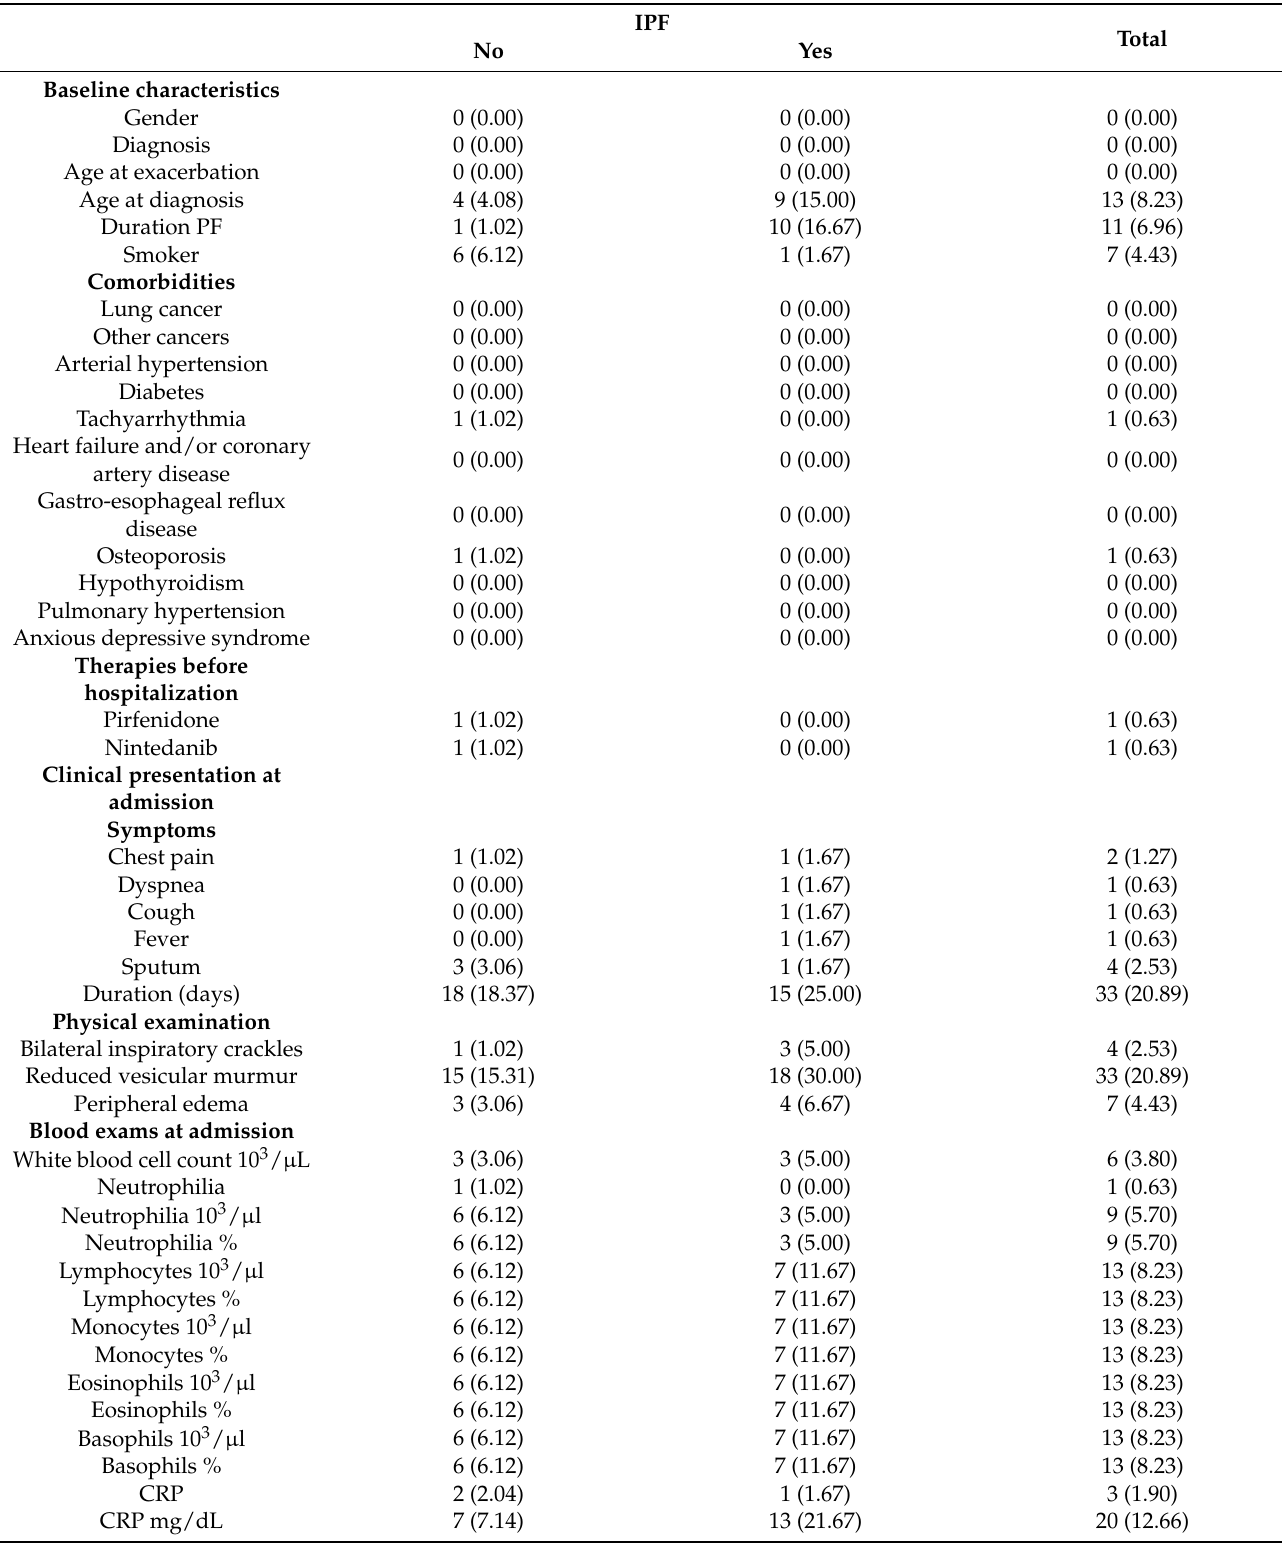
Table 4. Distribution of missing values for all analysed